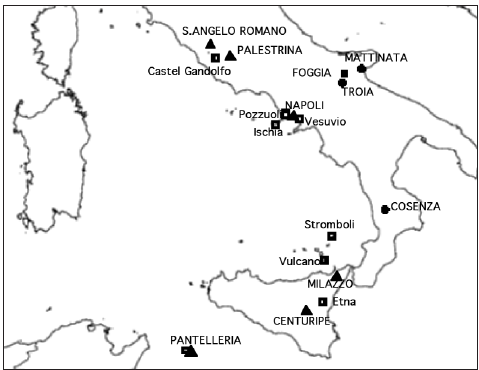
Fig. 6. Location of absolute stations in Southern Italy. Squares represent the reference stations for the relative gravity network, triangles represent the ab- solute stations located on the dynamic areas. Circles are the stations constituting the fundamental ties of the «Calibration line» for relative gravimeters and a station (Cosenza) settled in a seismic